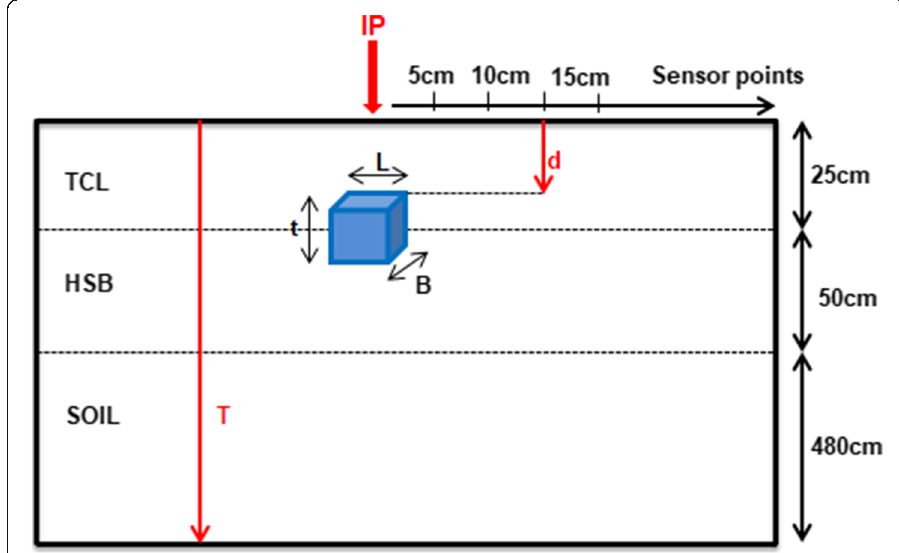
Fig. 11 Schematic for cavity location with the sensing